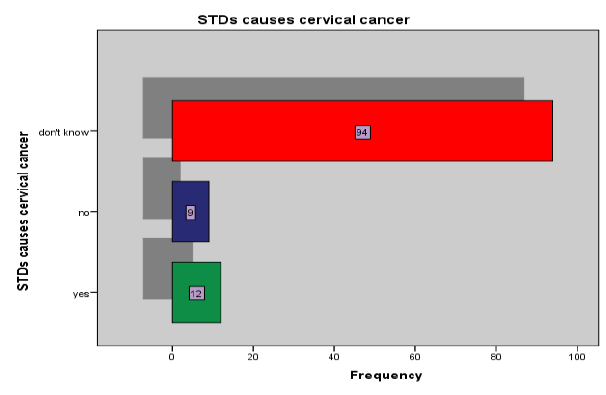
Figure 3: STDs causes cervical cancer